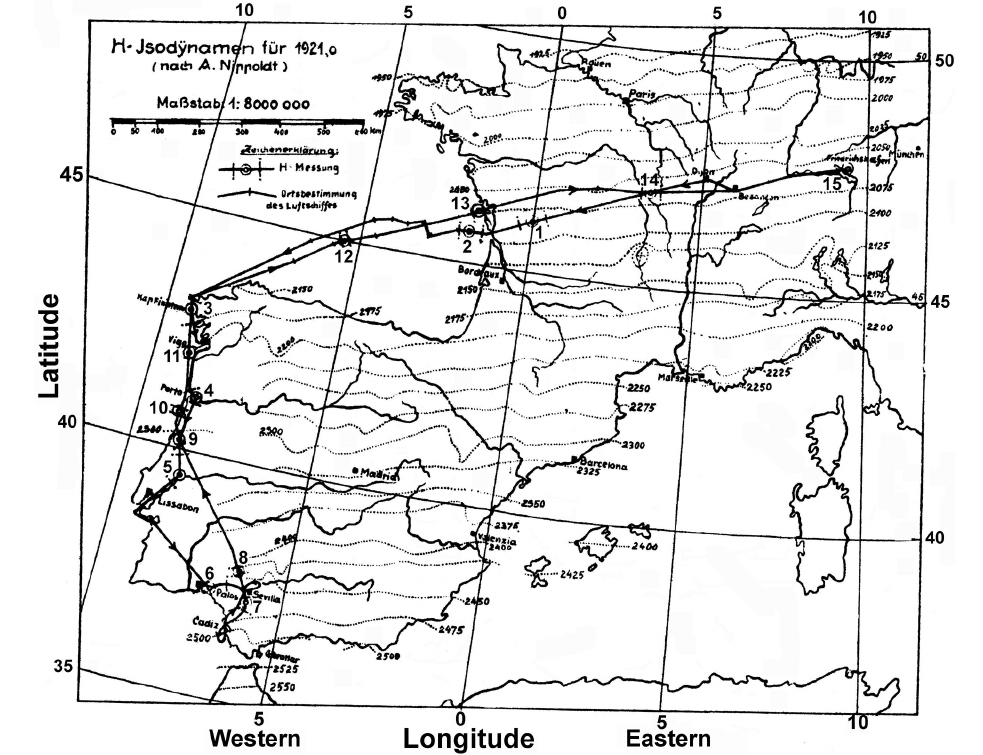
Figure 4. Map of the test flight of Graf Zeppelin over Europe (Grotewahl, 1930).